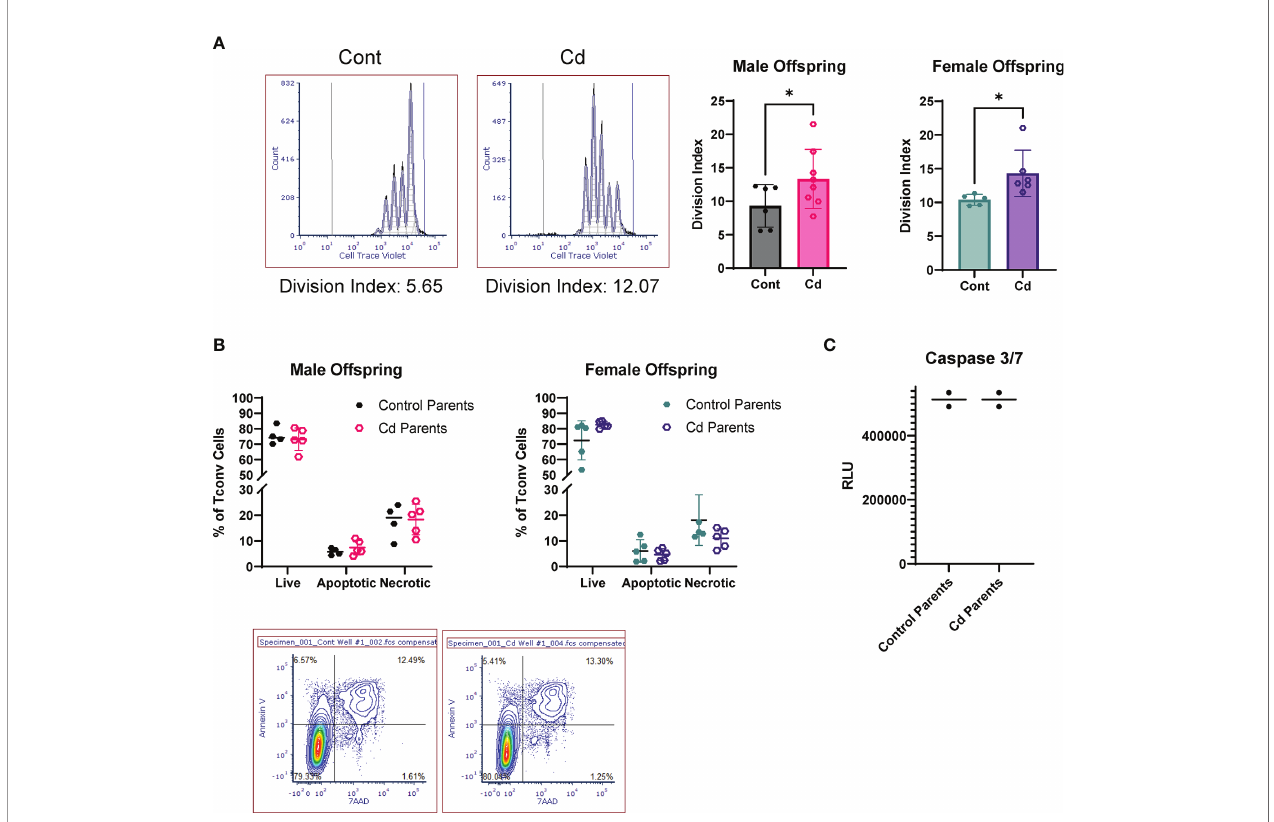
FIGURE 5 | Activated T Cells from Cd offspring have increased proliferation as compared to control offspring, but no differences in apoptosis. (A) Splenic CD4 + CD25 - T cells were labeled with Cell Trace Violet and stimulated with anti-CD3/CD28 magnetic beads for 72 h. Division index was calculated using FSC Express. A one-tailed, unpaired t-test was used to compare groups (n=5-8 per group); *p < 0.05. (B, C) Unlabeled T conventional cells were stimulated for 72 hours. Apoptosis was assessed by Annexin V/7AAD staining (B) and caspase 3/7 activity (C)